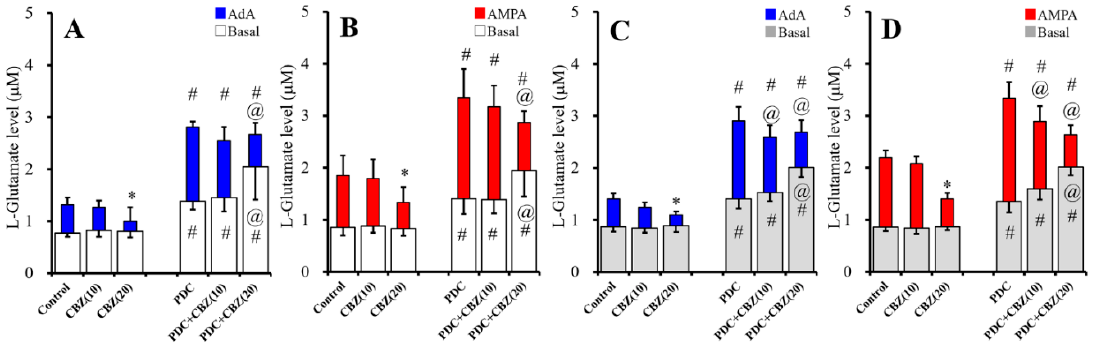
Figure 2. Effects of acute ( A , B ) and chronic ( C , D ) administrations of carbamazepine (CBZ) (10 and